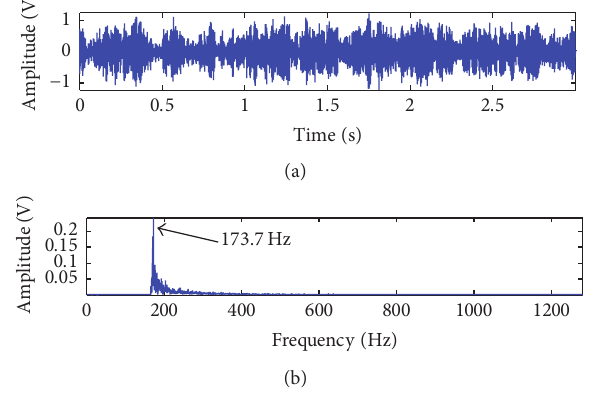
Figure 19: The statistical average of sensitive IMFs: (a) time-domain waveform; (b) frequency